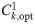
Decoder inferred using the extensive information model.(A) Decoding weights were inferred in the subspace of 2 leading principal components of noise covariance (solid circles). Inset: These components lie entirely within the space spanned by neurons in one of the two brain regions. Components are color coded according to the brain region that it inhabits (red=VIP; blue=MSTd). (B) Experimentally measured choice correlations (Ck) of individual neurons in VIP (red) and MSTd (blue) are plotted against their respective components Ck,opt1 and Ck,opt2 of choice correlations generated from optimally decoding responses within the subspace of 2 leading principal components. (C) Unlike the optimal decoder in Fig 4B, the behavioural threshold predicted by the inferred weights (black) saturates at a population size of about 100 neurons. The green line indicates the performance of an optimal decoder within the two-dimensional subspace. Inactivating VIP is correctly predicted to have no effect on behavioural performance for large N (blue), while MSTd inactivation increases the threshold (red). (D) A schematic of the inferred decoding solution projected onto the first principal component of noise in VIP and MSTd. The solid colored lines correspond to the readout directions for the four cases shown in (c). The long diagonal black line is the projection of the mean population responses for headings from –9° to +9°, and the two gray ellipses correspond to the noise distribution at heading directions of ±2°. The colored gaussians correspond to the projections of this signal and noise onto each of the four readout directions, and the overlap between these gaussians corresponds to the probability of discrimination errors. (E) The percentage of available information read out by the inferred decoder (the decoding efficiency) decreases with population size, because the decoded information saturates while the total information is extensive. (F) Correlations between MSTd and VIP were not measured experimentally. We modeled these correlations according to the same linear trend that on average described correlations within each population, but with different slopes, yielding different interareal correlations parametrized by γ = εMV/εMM (Methods). This slope reaches its maximum allowable value γmax=εVV/εMM, the geometric mean of the slopes for MSTd and VIP. (G) For each value of γ, we used the resultant covariance and CCs to infer the decoder, and plotted its behavioural thresholds. Thresholds are shown for a population of 256 neurons, by which point the performance had saturated to its asymptotic value for all γ. Shaded regions in (c), (e), and (g) represent ±1 SEM.